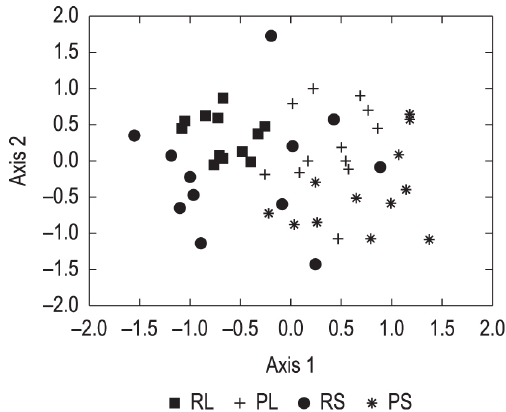
Figure 5. Non-metric multidimensional scaling (NMDS) for the density of benthic invertebrates in the micro- habitats of the streams of the Iguaçu National Park. RL: riffle litter, PL: pool litter, RS: riffle sediment, PS: pool sediment.